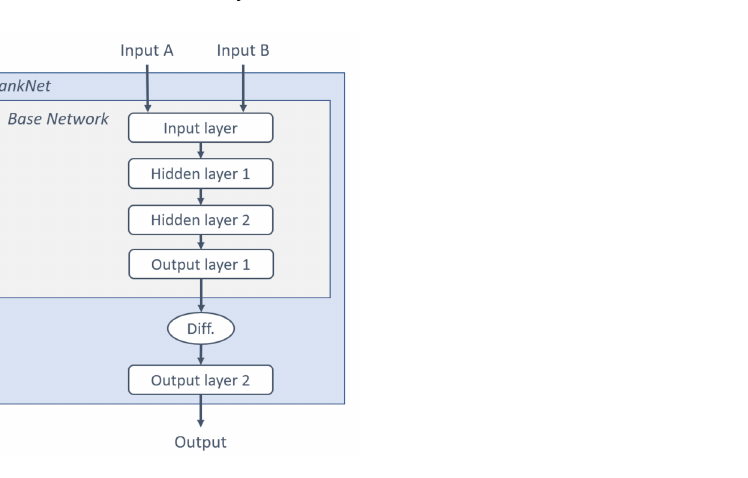
Figure 2. The sequential block diagram of the RankNet network used in the study. Table 1. The number of neurons and the applied activation functions in the layers of the RankNet network designed for the